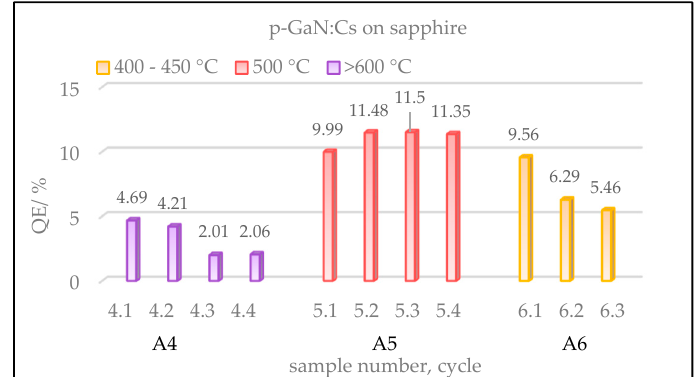
Figure 4. Gained QE values of p-GaN:Cs on sapphire photocathodes, depending on various temperatures used in the thermal cleaning. Sample A4 (violet) was cleaned at over 600 °C and activated for four cycles. Sample A5 (red) was cleaned at 500 °C and activated for four cycles, while sample A6 (yellow) was cleaned at 400–450 °C and activated for three cycles.